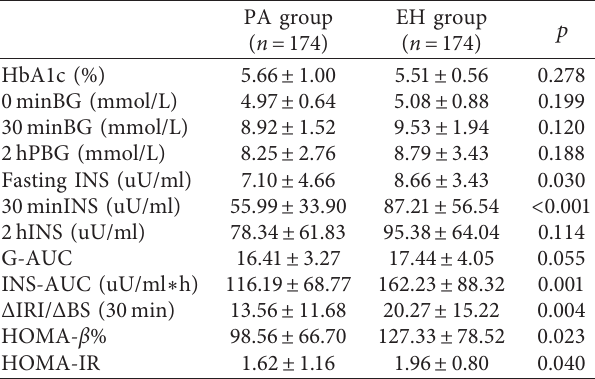
BG: blood glucose, INS: insulin, G-AUC: AUC of glucose, INS-AUC: AUC of insulin, Δ IRI/ Δ BS: the ratio of the net increase in blood insulin ( Δ IRI) to the net increase in blood glucose ( Δ BS) 30minutes after OGTT.